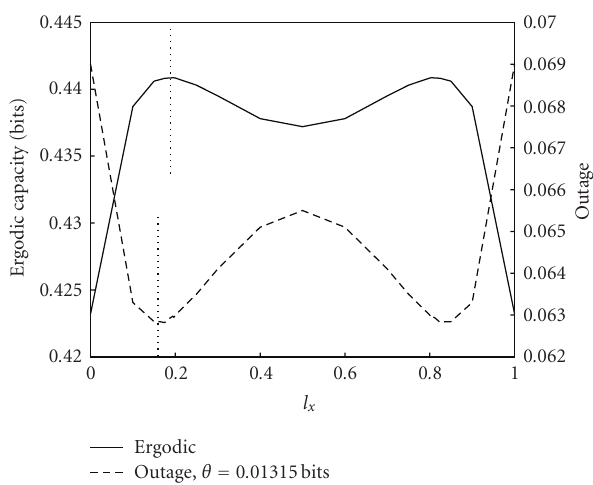
Figure 4: Ergodic capacity and outage ( θ = 0 . 01315) of AF versus the location of the relay, δ = 2, E s = 0 . 24, N 0 = 1, l y = 0 . 05, and l SD =